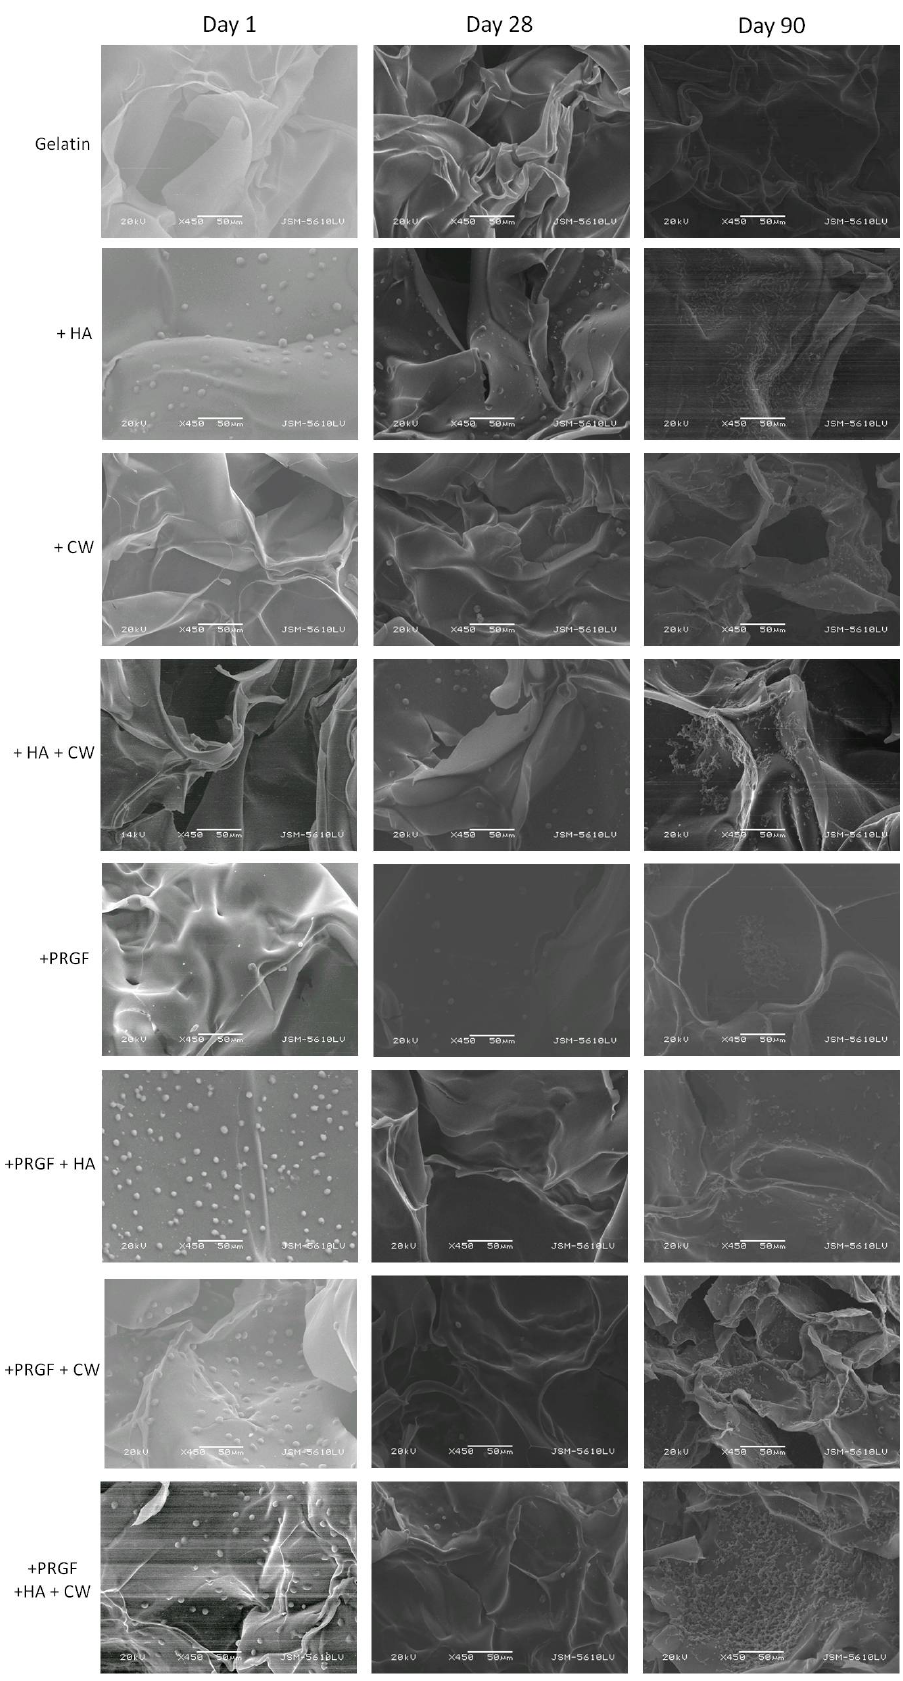
Figure 4. SEM of post cross-linked scaffolds seeded with MG-63 cells for 1, 28, and 90 days. Magnification at 450× and scale bars at 50